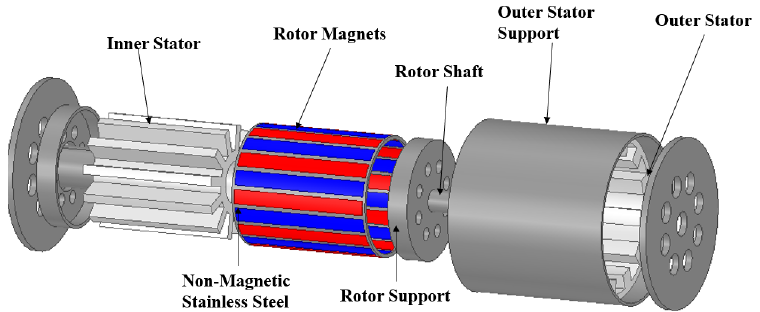
Figure 14. The layout of the PMVM model with a yokeless rotor.